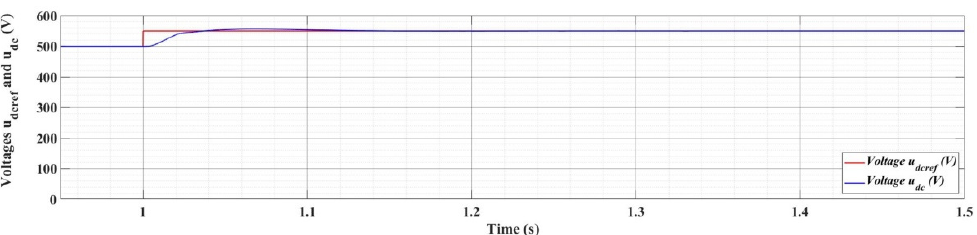
Figure 33. The time evolution of the u dc voltage for a step variation of u dcref from 500 V to 550 V using PI controllers (signal evolution of the type 1 PV array).